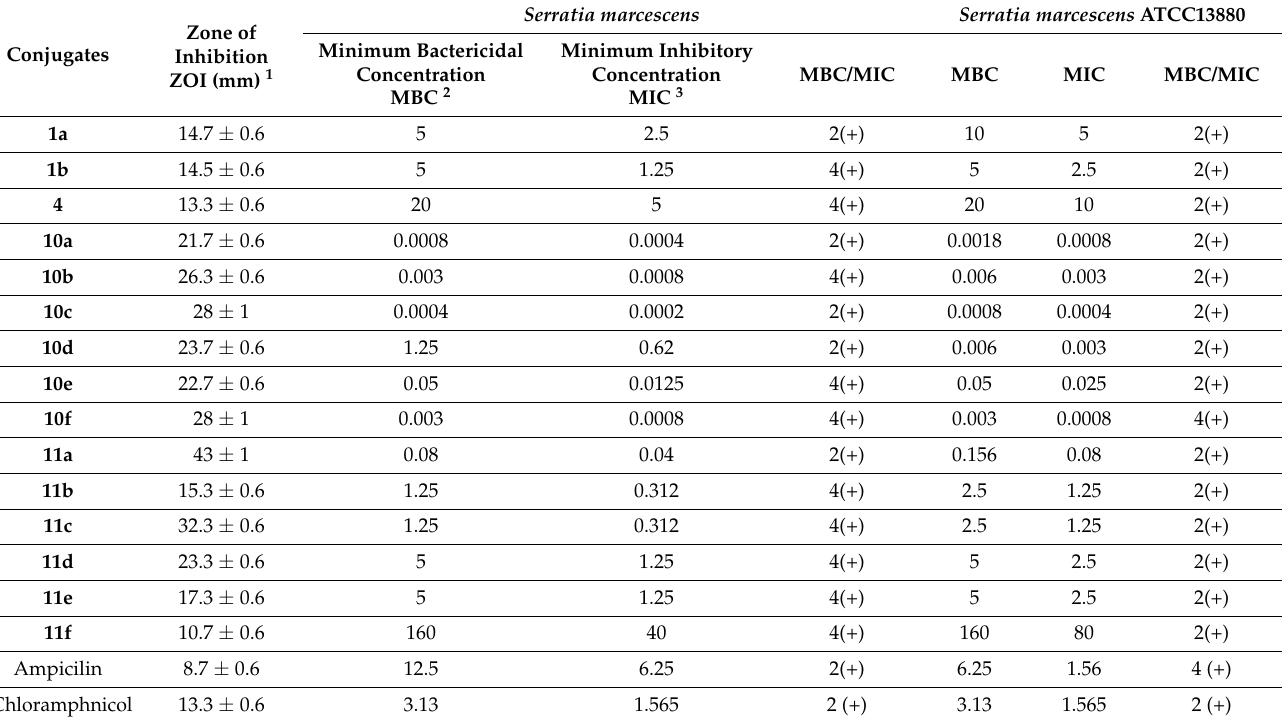
Table 5. Antibacterial activity of conjugates 10a – f and 11a – f against the Serratia marcescens clini- cal